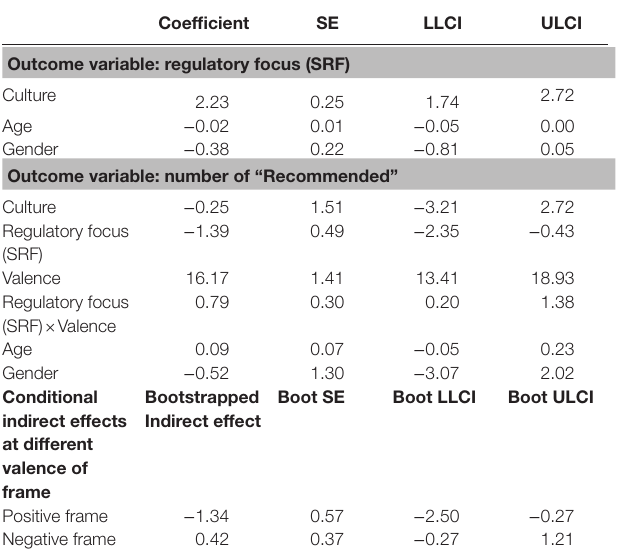
TABLE 1 | Moderated mediation results of Study